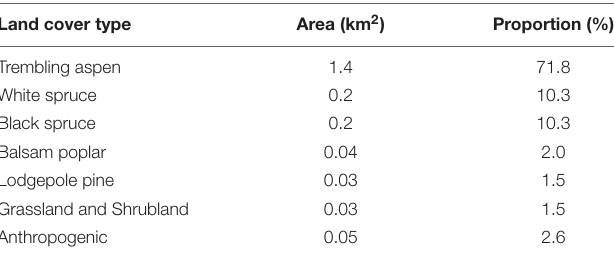
TABLE 2 | Details pertaining to the land cover in the retention patches (as operationally implemented or planned); derived from the Alberta Vegetation Inventory (Alberta,